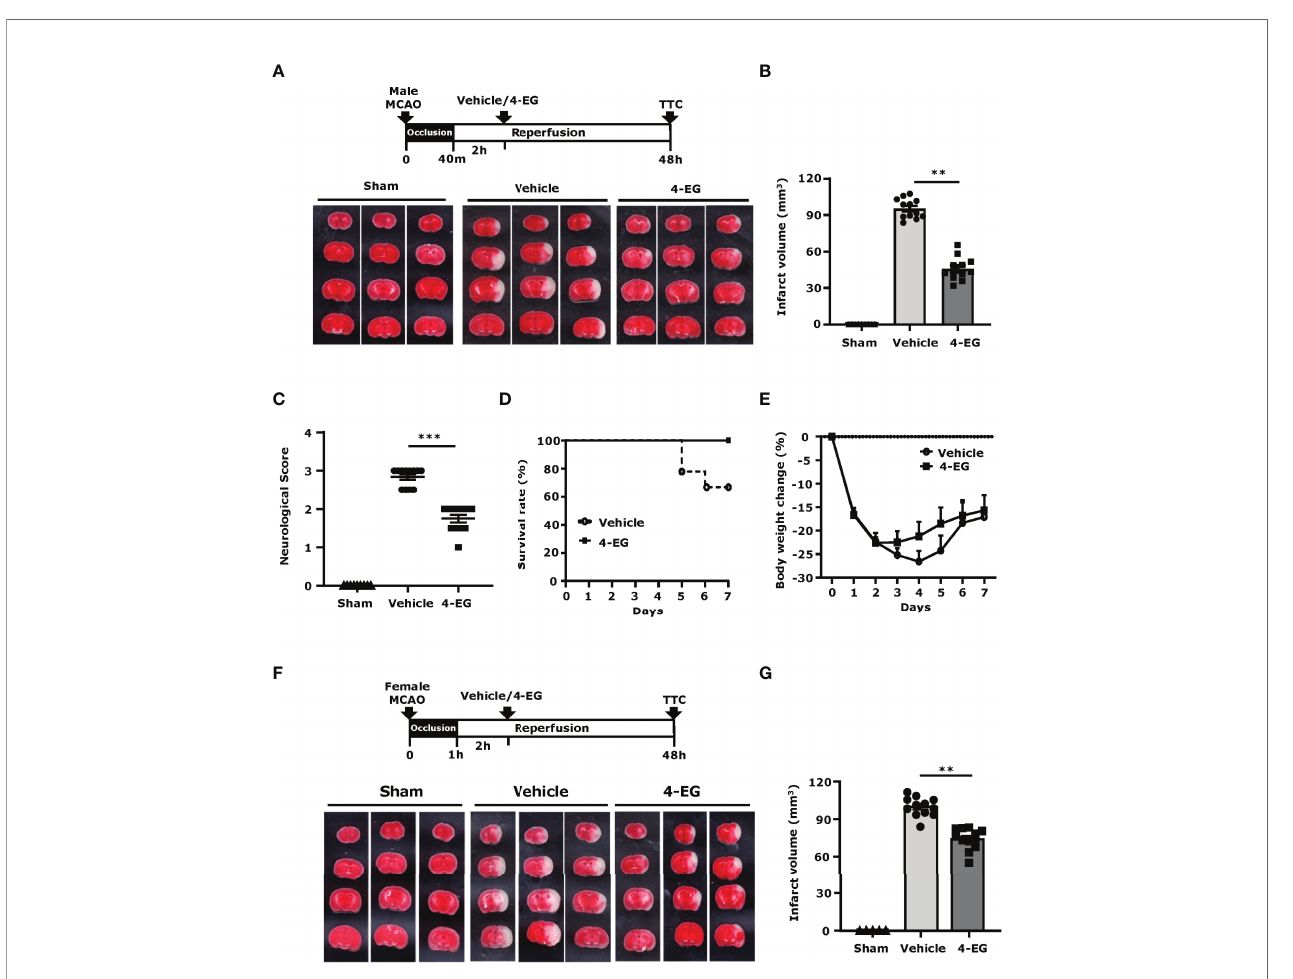
FIGURE 1 | 4-EG ameliorates brain injury and increases survival in ischemic stroke. (A – E) C57BL/6 male mice were subjected to sham or 40 min MCAO followed by vehicle or 4-EG (100 mg/kg) i.v. administration at 2 h post-reperfusion. (A) At 48 h post-injury, mice were sacri fi ced, and the ischemic brains were harvested and sliced (2 mm) followed by TTC staining. Three representative TTC-stained brain samples of sham, and vehicle- and 4-EG-treated MCAO mice are shown. (B) The infarct volumes and (C) neurological scores of sham (n=10), and vehicle- and 4-EG-treated MCAO mice (n=12/group) were evaluated. ** p < 0.01 , *** p < 0.001 by the Kruskal – Wallis test. (D) The survival rate and (E) body weight change of vehicle- and 4-EG-treated MCAO mice were evaluated up to day 7 post-injury (n=9/ group). (F, G) C57BL/6 female mice were subjected to sham or 1 h MCAO followed by vehicle or 4-EG (100 mg/kg) i.v. administration at 2 h post-reperfusion. (F) Three representative TTC-stained brain samples of sham, and vehicle- and 4-EG-treated MCAO are shown, and (G) the infarct volumes of sham (n=5), and vehicle- and 4-EG- treated MCAO female mice (n=10/group) were assessed. ** p < 0.01 by the Kruskal – Wallis